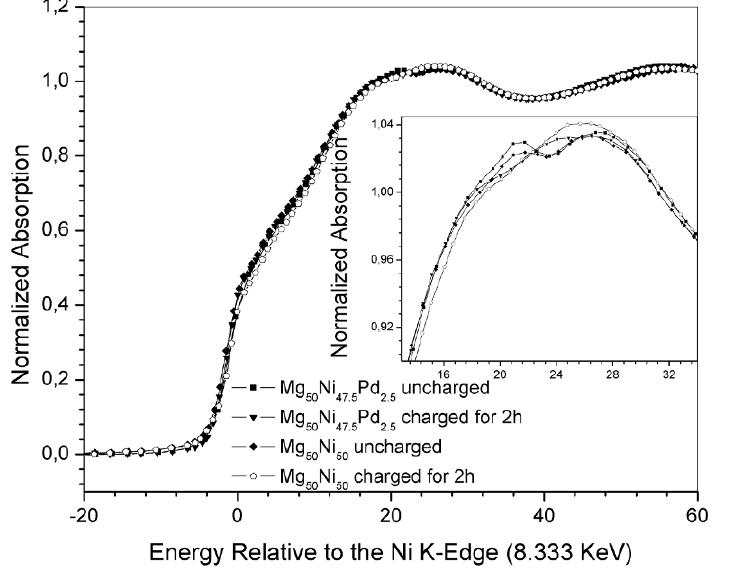
Ni Pd alloy. 50 47.5 2.5